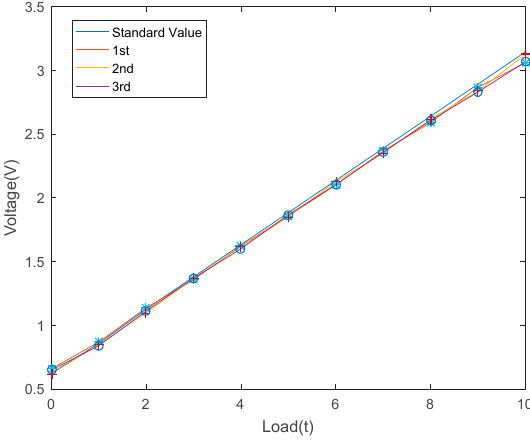
Figure 25. Linearity experiment results of the sensor.